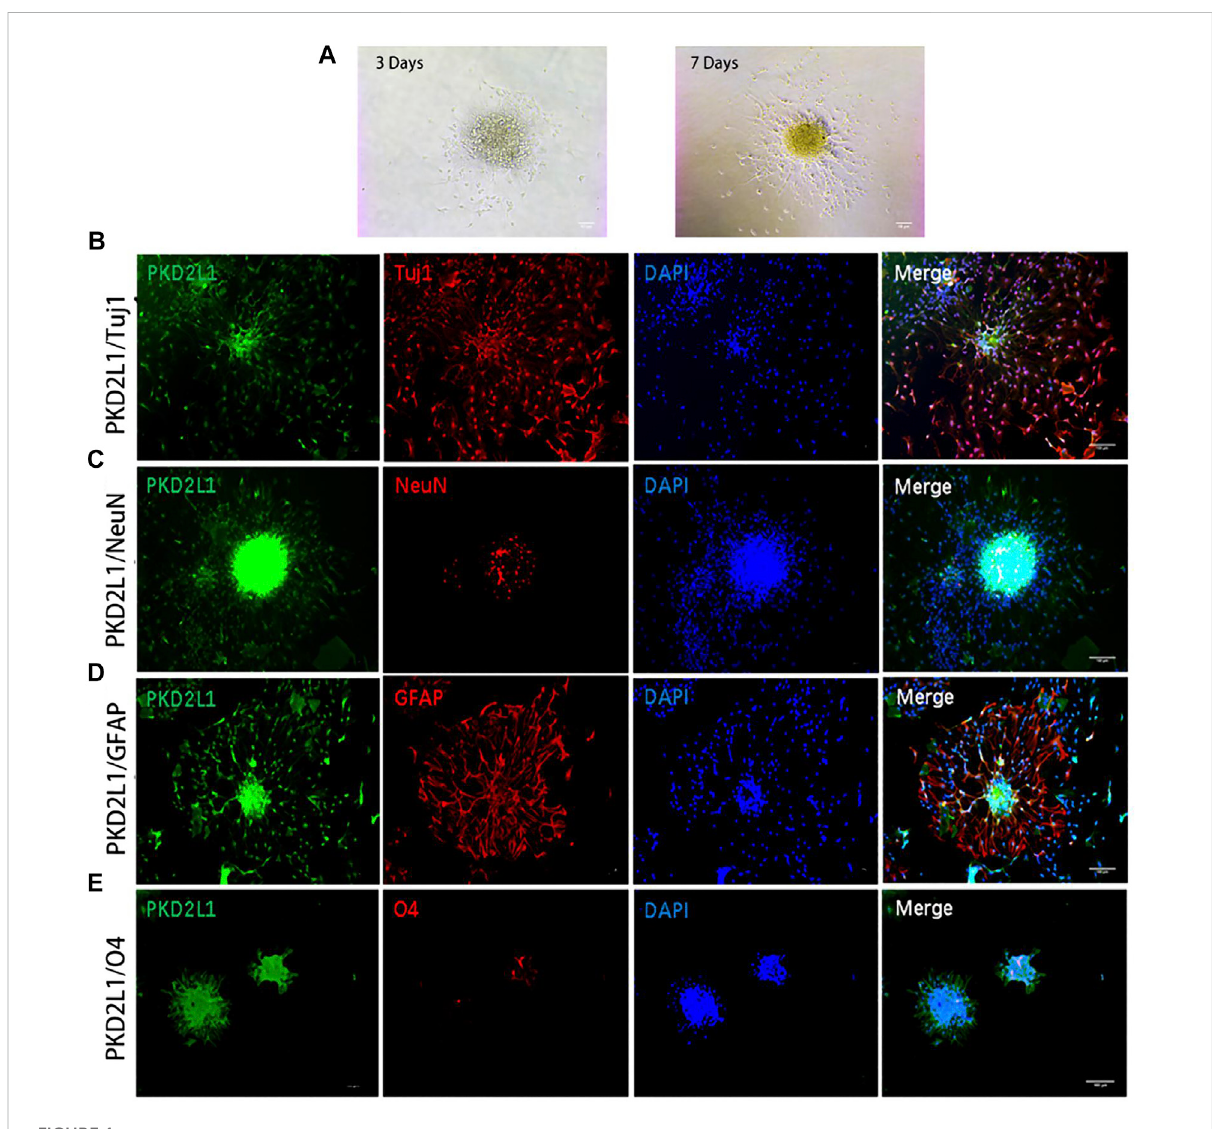
FIGURE 1 Neurospheres formed by CSF-cNs were tri-potent (Wang S. et al., 2021). (A) Differentiation of neurospheres after adherent culture on Days 3 and 7. (B – E) Immuno fl uorescence analysis showing that neurospheres differentiated into neurons that were positive for Tuj1 (B) and NeuN (C) , astrocytes that were positive for GFAP (D) , and oligodendrocytes that were positive for O4 (E) , respectively. Scale bar represents 50 μ m in (A) and 100 μ m in (B –